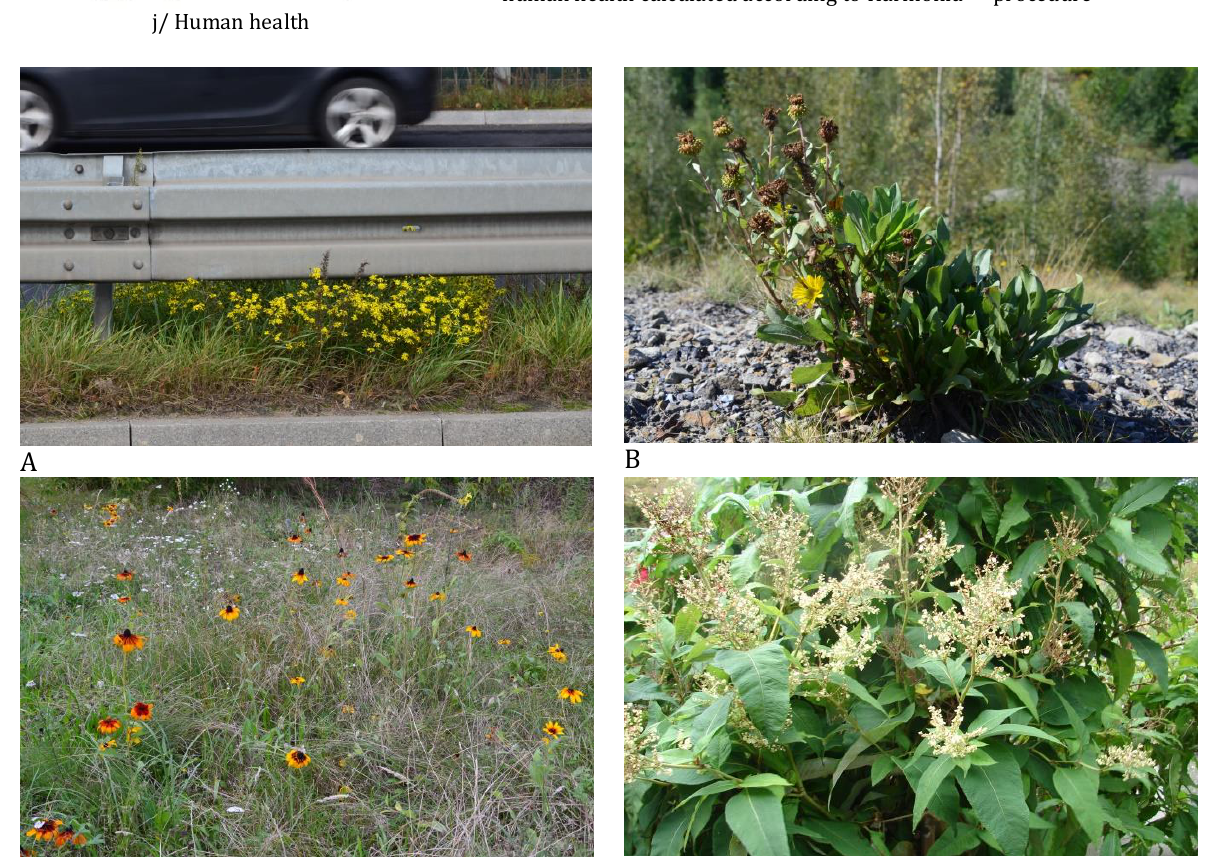
Fig. 7. The dynamic nature of biological invasions makes it necessary to regularly review and update risk assessments (photo: Barbara